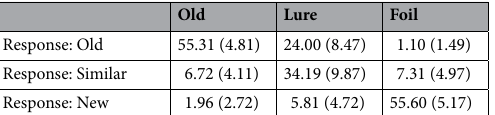
Table 1. Responses (mean score (maximum = 64) and standard deviations) for each stimulus and response type of the Mnemonic Similarity Task for objects ( n =